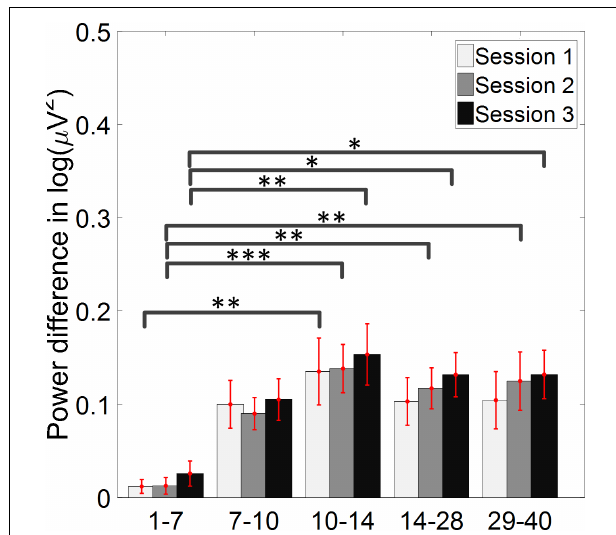
FIGURE 9 | Log power spectra difference between channel C3 and channel C4 of five frequency bands across three training sessions. The log power difference between ipsilateral and contralateral hemisphere, with respect to the direction of movement imagination, was shown. There was no significant difference across the three training sessions in any of the five frequency bands. ∗ p < 0.05, ∗∗ p < 0.01, ∗∗∗ p <